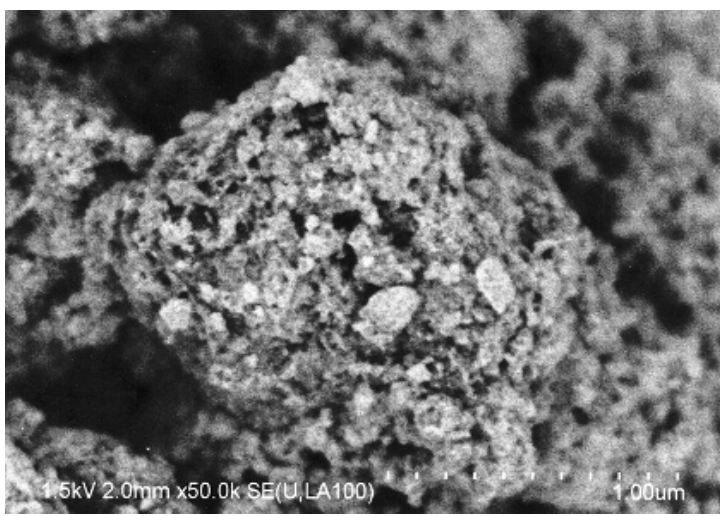
O +Cs2.5 (mass ratio = 1:1) after grinding for 30 2 3